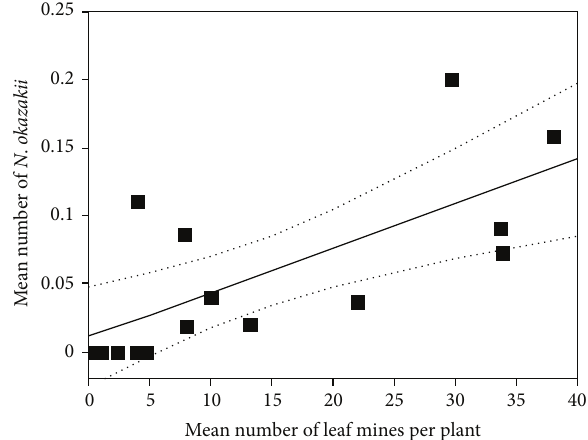
Figure 1: Relationship between levels of leaf miner infestation of green onion fields and mean numbers of Neochrysocharis okazakii found per plant. Dot lines indicate 95% confidence